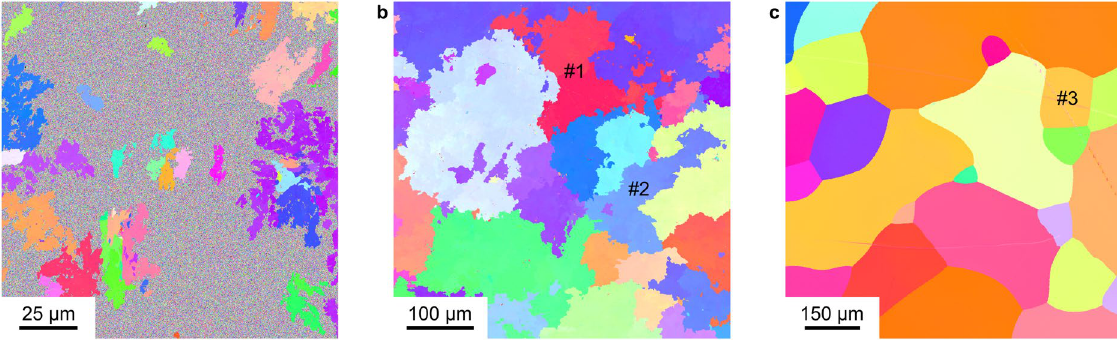
Figure 1. Microstructural maps of abnormal grain growth in nanocrystalline Pd-10 at% Au, recorded by electron backscatter diffraction (EBSD) following heat treatments of ( a ) 155 °C for 202 h and ( b ) 400 °C for 4 h. The speckled contrast visible between single-color micrometer-sized regions in ( a ) is caused by the presence of grains smaller than the point resolution of the EBSD technique at this magnification (0.15 μ m). The perimeters of abnormal grains in ( a ) and ( b ) are much rougher and more convoluted than the smooth boundaries seen in ( c ), which represents the microstructure of a Pd-10 at% Au sample prepared by arc melting and subsequent